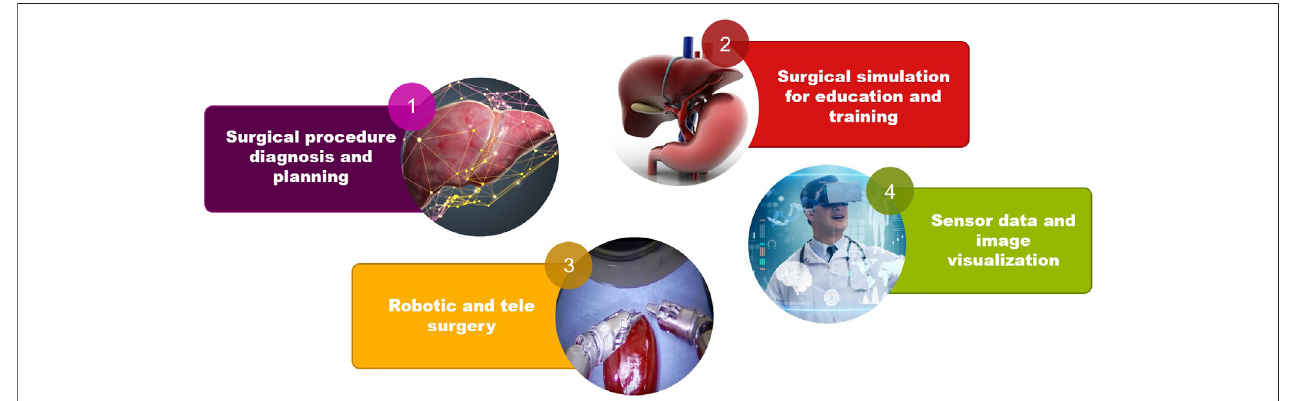
FIGURE 3 | VR/AR applications in surgical